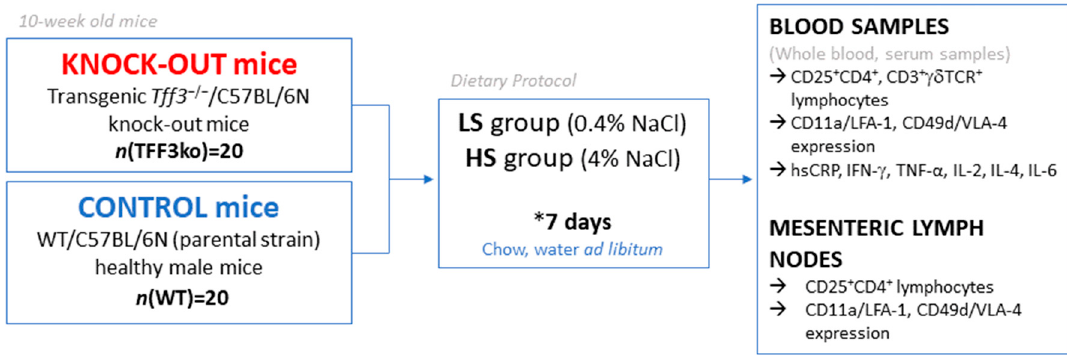
Figure 10. Schematic representation of the study design.